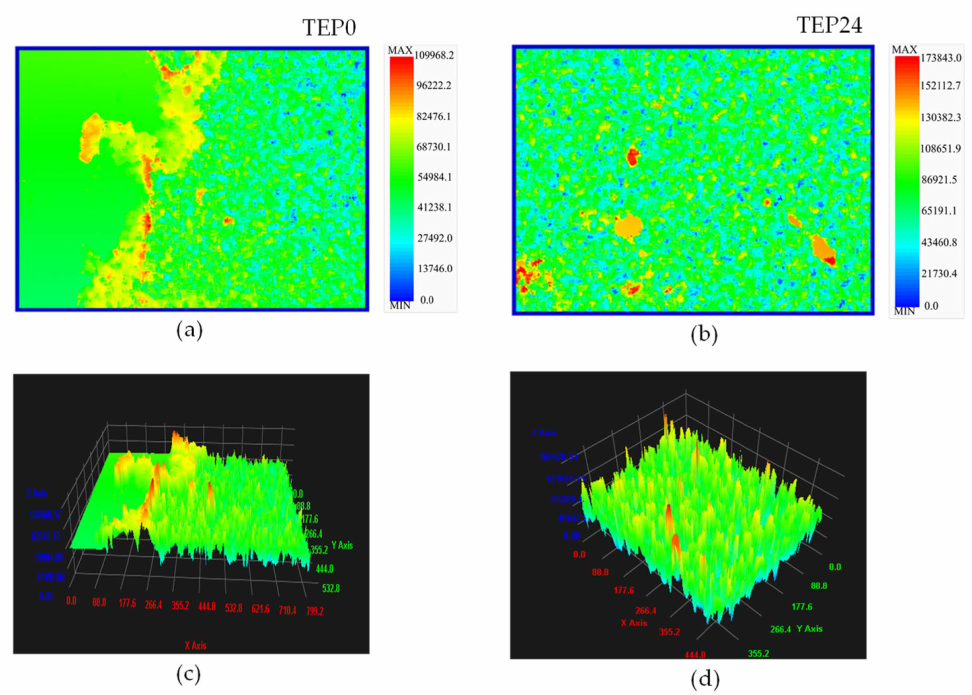
Figure 2. ( a ) 2D surface profile and ( b ) 3D surface profile of TEP0 and ( c ) 2D surface profile and ( d ) 3D surface profile of